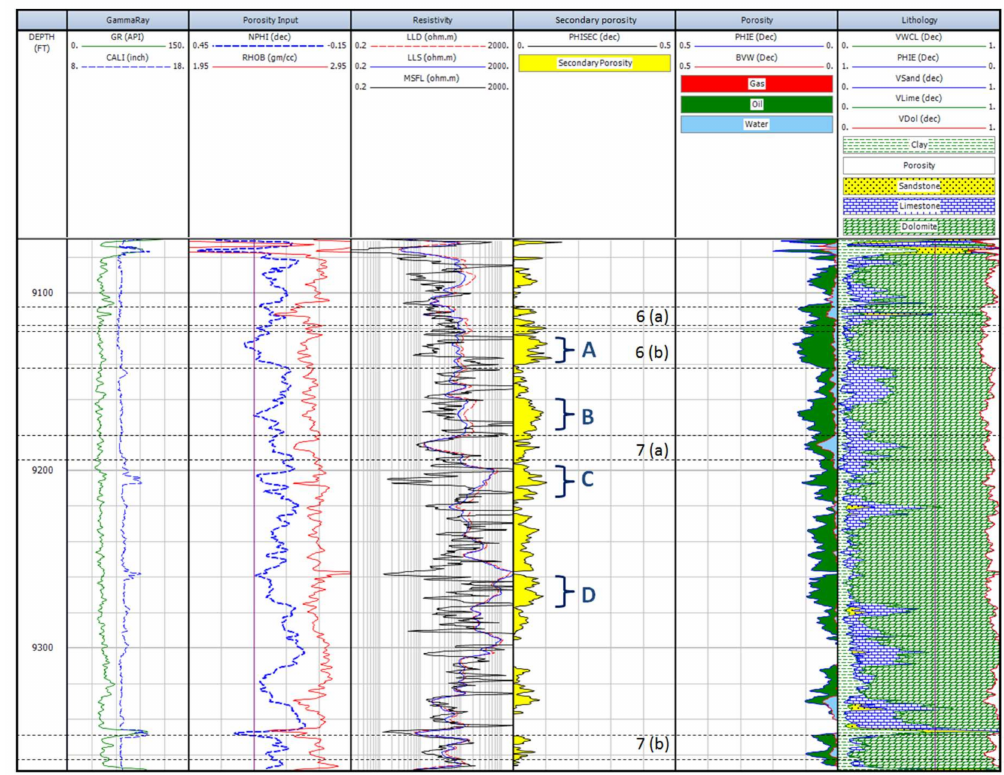
Figure 3. Analysis of well logging data for Tourmaline-1X showing high secondary porosity in the Alamein Formation, where zones with greatest secondary porosity are labeled ( A – D ), and 6( a )–6( b ) and 7( a )–7( b ) are intervals where image log is